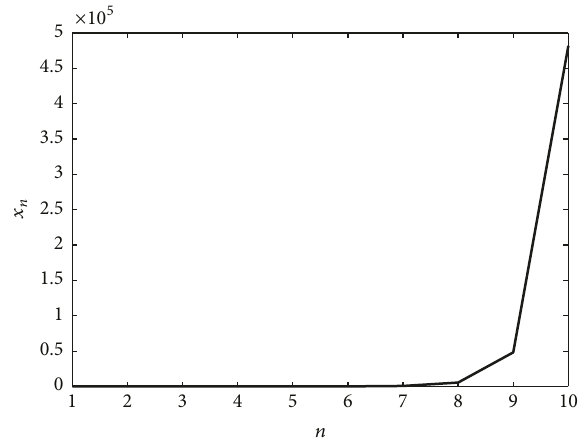
Figure 1: Problem (35): unbounded 𝑥 𝑛